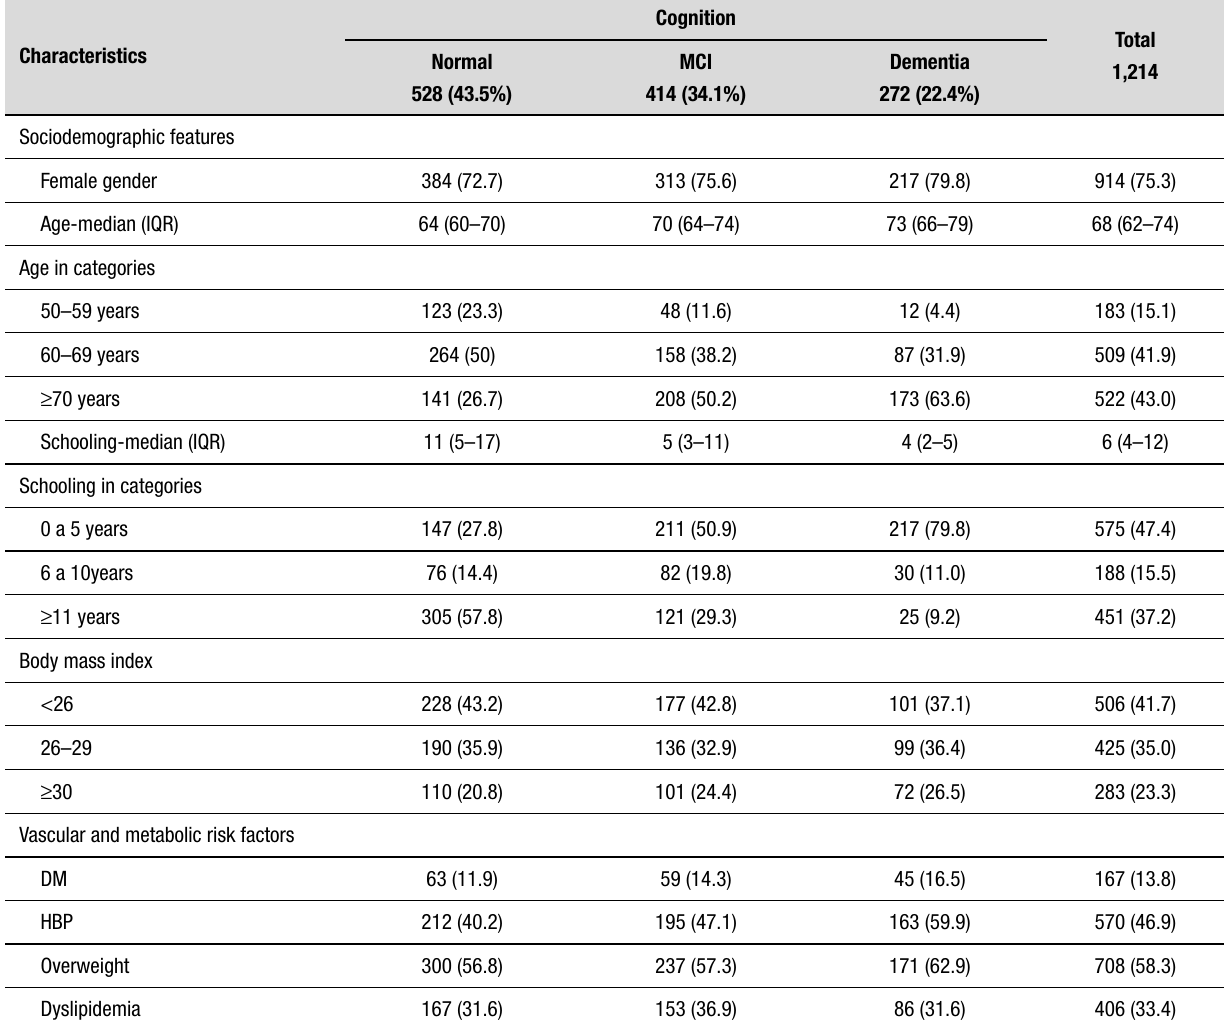
Table 1. Absolute and relative frequency of sociodemographic characteristics, and vascular and metabolic risk factors according to cognitive status.